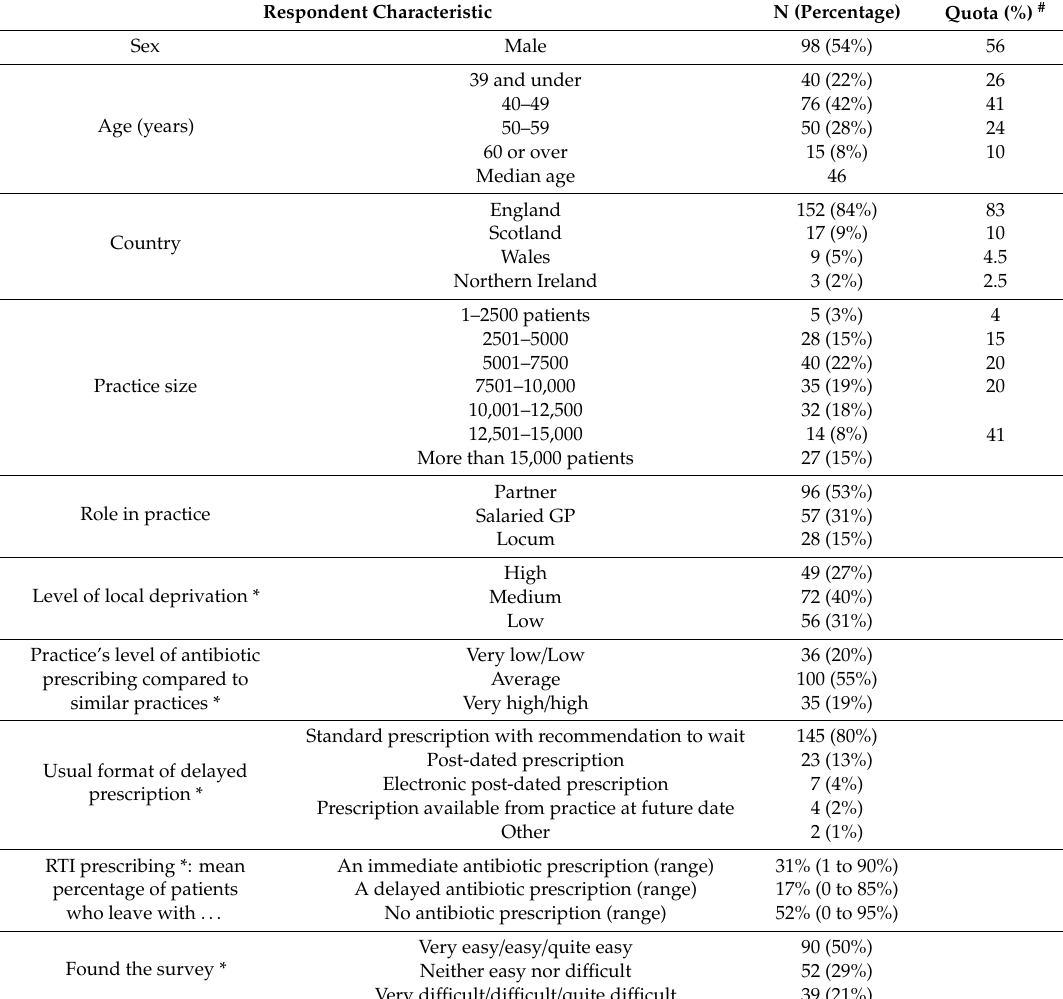
Table 2. Respondent